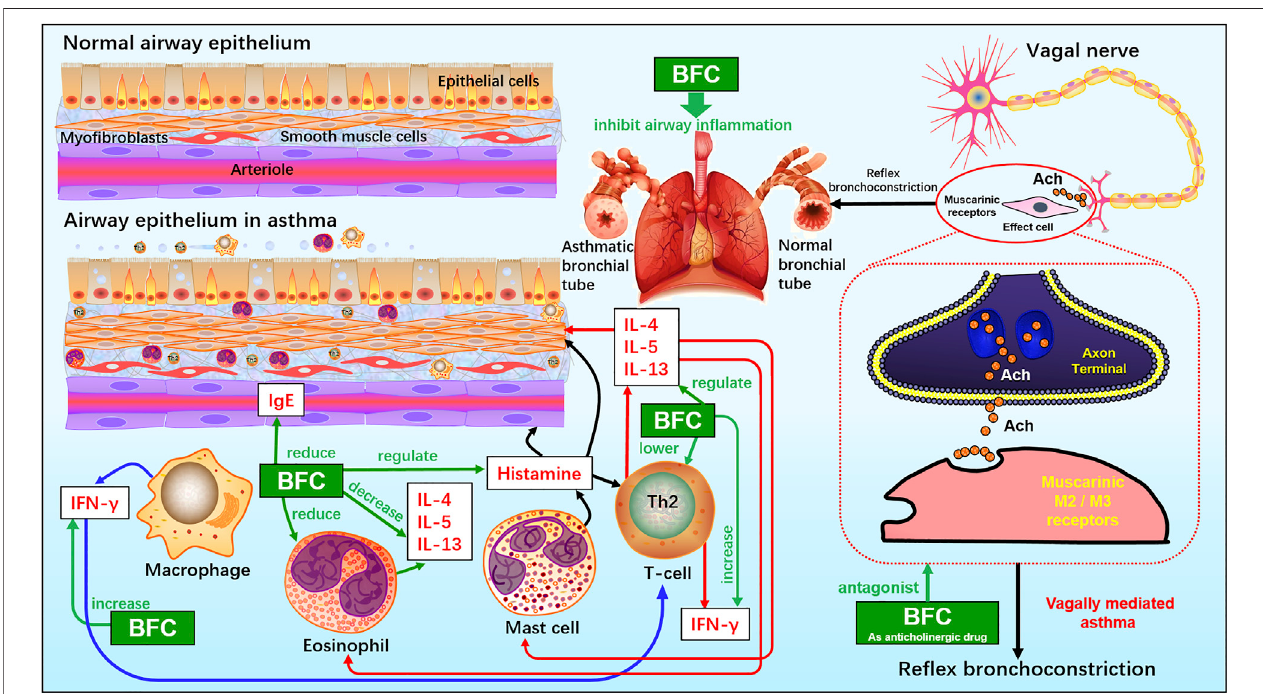
FIGURE 3 | The molecular mechanism of BFC for the inhibitory effect on asthma and bronchial in fl ammation.